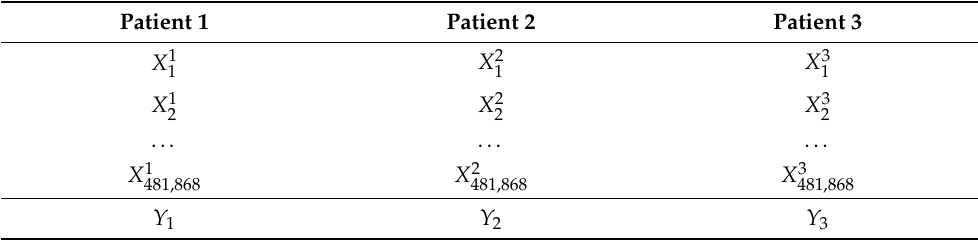
Table 5. Multiple patient methylation data (general data structure).